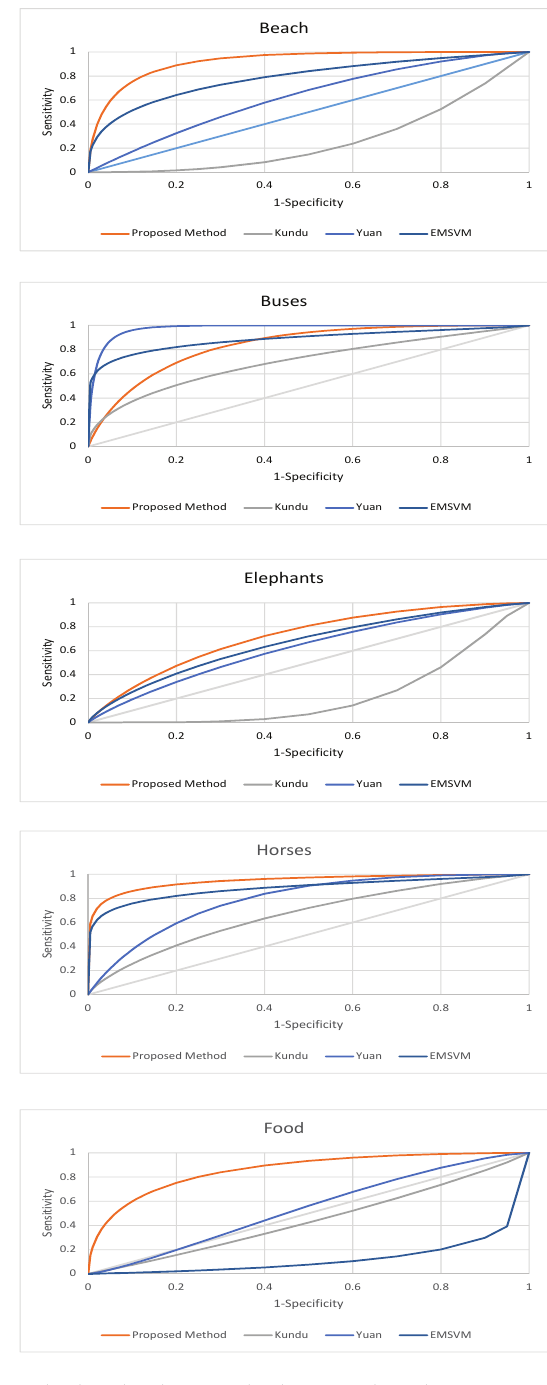
Figure 10. Performance evaluation of the proposed method with other standard content-based image retrieval (CBIR) systems Kundu et al. [49], Yuan et al. [54], and Ensemble based SVM (EMSVM) [42] using the receiver operating characteristic (ROC)